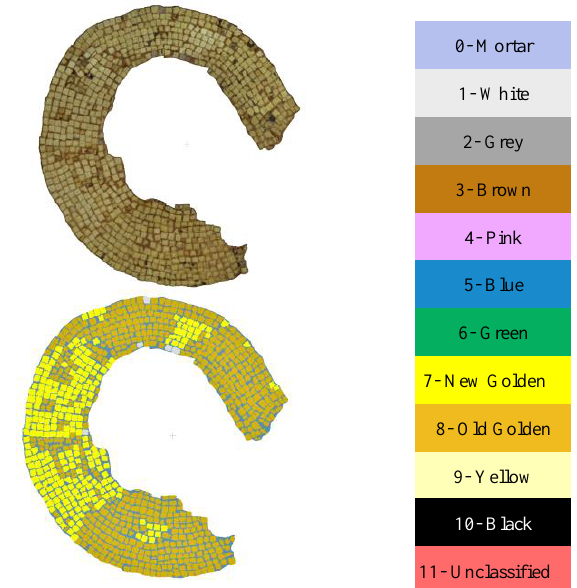
Figure. 1 Part of our dataset: point cloud in RGB colours (top), labelled point cloud (bottom) (The code colour is conserved for the rest of the